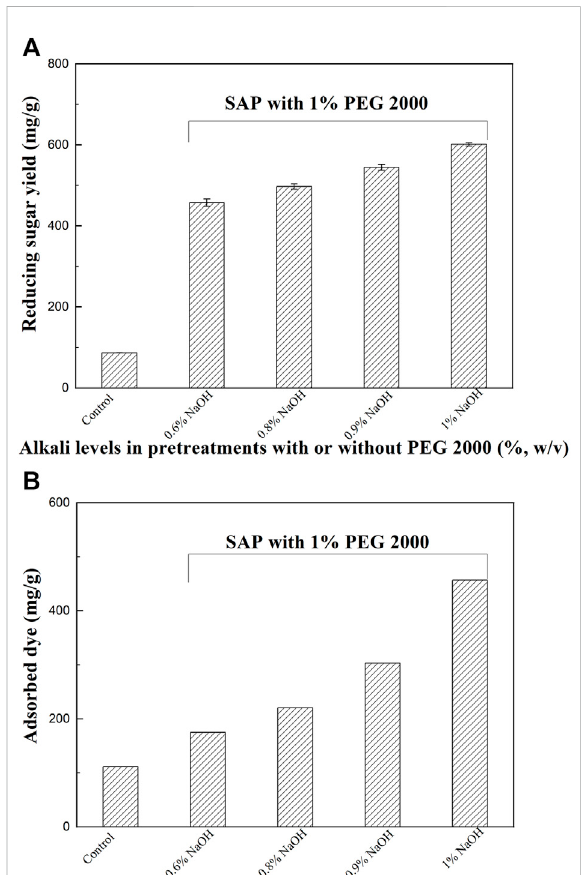
FIGURE 5 The effect of alkali concentrations in PEG 2000-mediated SAP on enzymatic hydrolysis (A) and accessibility (B) of these pretreated